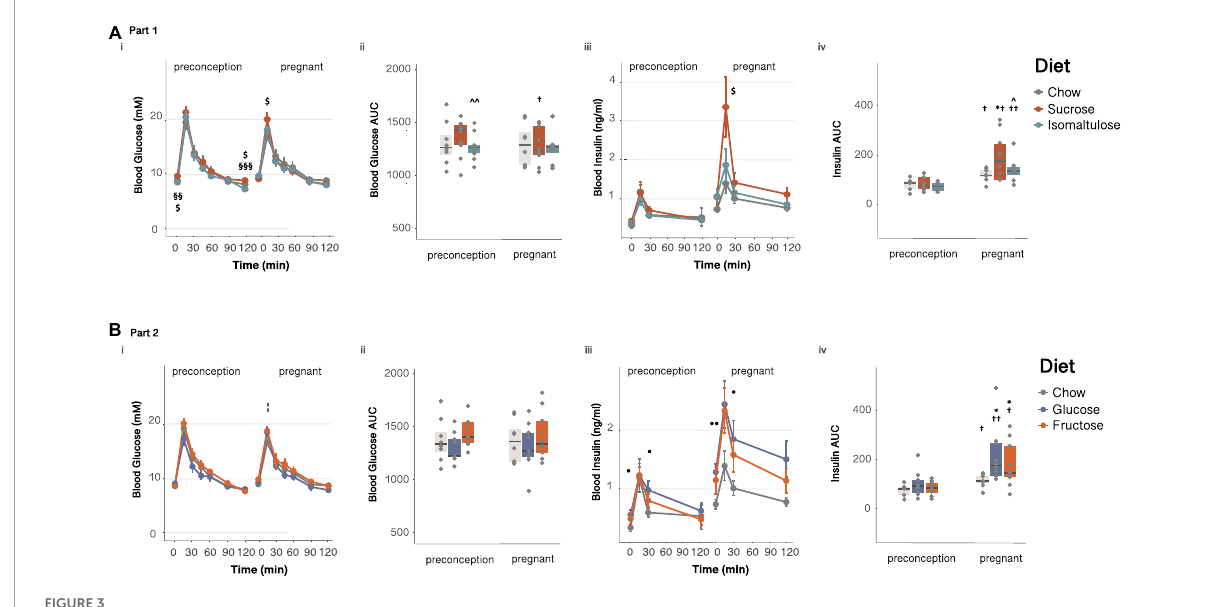
FIGURE3 Glucose homeostasis in dams (A) in Part 1 and (B) in Part 2: Dam response to an oral glucose tolerance test before and during pregnancy (i) glucose over time, (ii) glucose AUC, (iii) insulin over time and, (iv) insulin AUC. n = 8–10 per diet. Line graphs depict data as mean ± SEM. * p < 0.05 vs. chow; ˆ p < 0.05 vs. sucrose; ˆ ˆ p < 0.01 vs. sucrose; $ p < 0.05 sucrose vs. chow; p < 0.01 sucrose vs. isomaltulose; p < 0.001 sucrose vs. isomaltulose; · p < 0.05 glucose vs. chow; ·· p < 0.01 glucose vs. chow; p < 0.05 fructose vs. chow; † p < 0.05